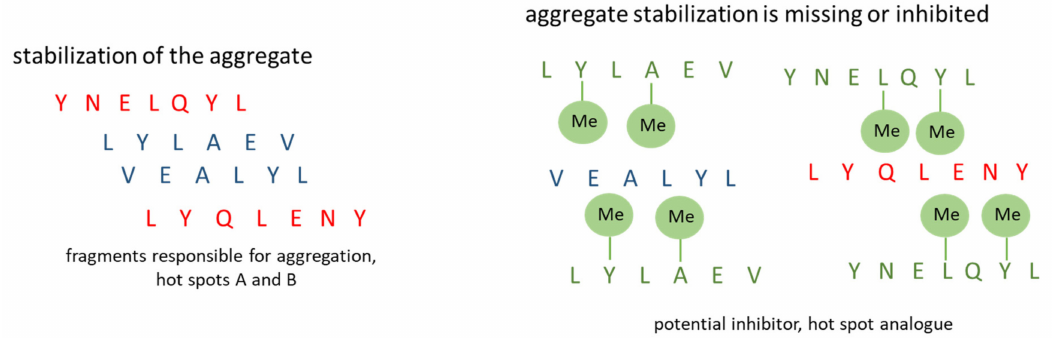
Figure 3. Model of a 1:2 complex consisting of one hot-spot molecule and two molecules of N -methylated